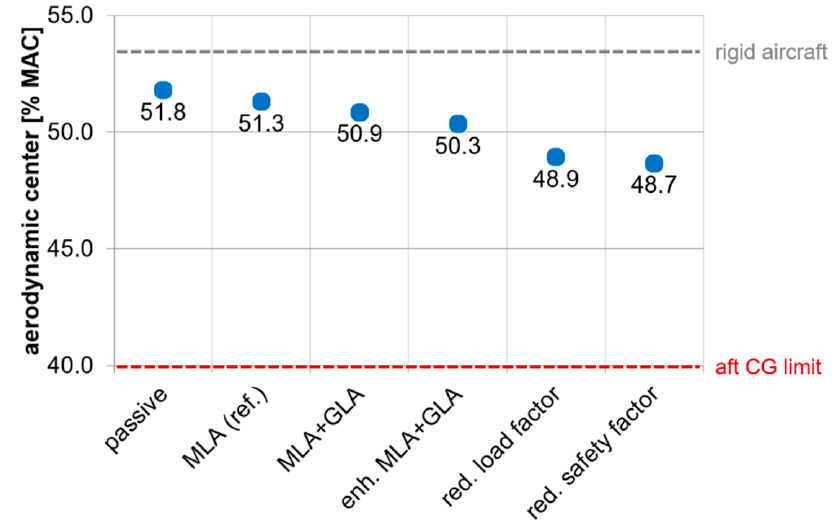
Figure 46. Overview of the location of the aerodynamic center.